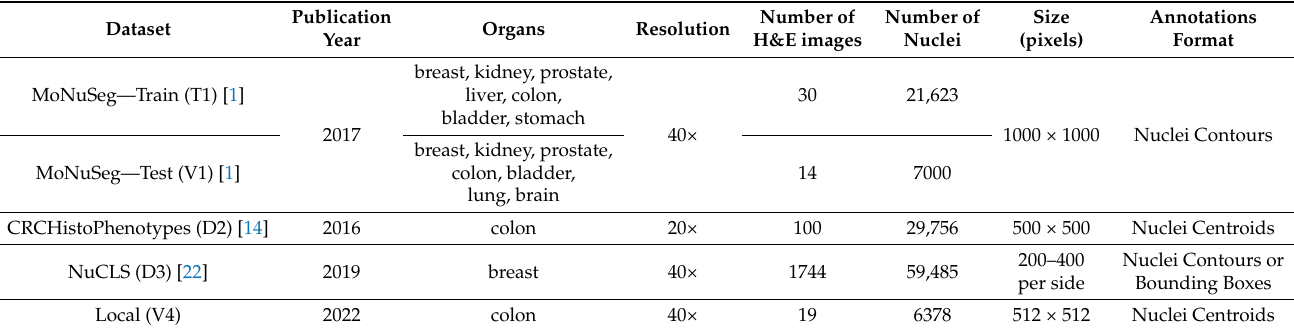
Table 1. Summary of datasets for